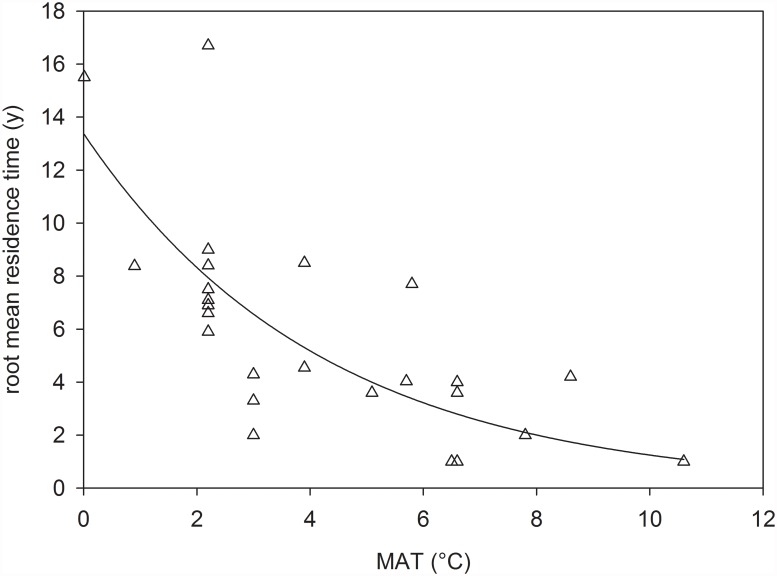
Mean annual temperature and root carbon mean residence time (0–10 cm) of all sampling plots.The curve displays the exponential relationship mean residence time (y) = 13.38 [1.94] * exp(-0.24 [0.05] * x), R2 = 0.53,P < 0.001. Values in square brackets are 1 SE.